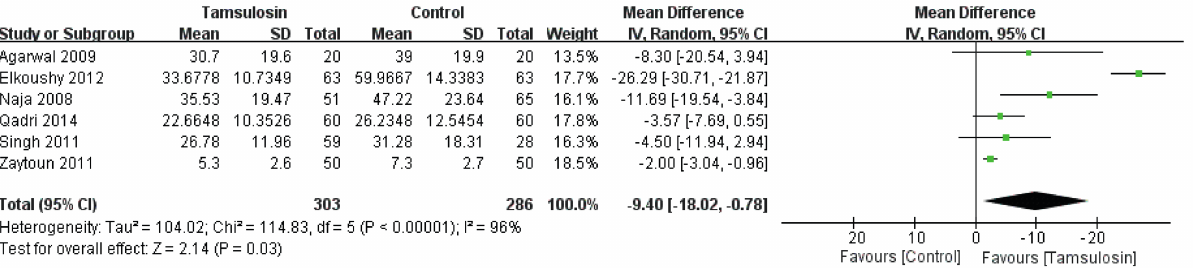
Figure 4 - Forest plots with clearance time as the